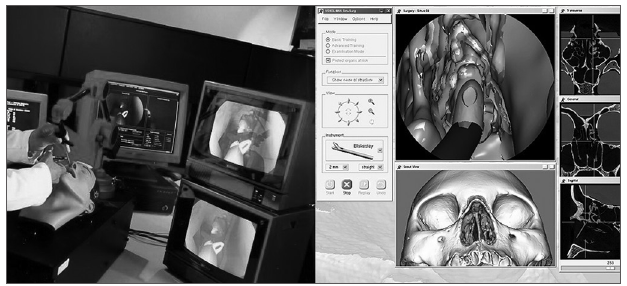
Figura 4. Simulador virtual de cirurgia endoscópica nasossinusal, denominado de ES3. Ao lado, imagem da tela de computador